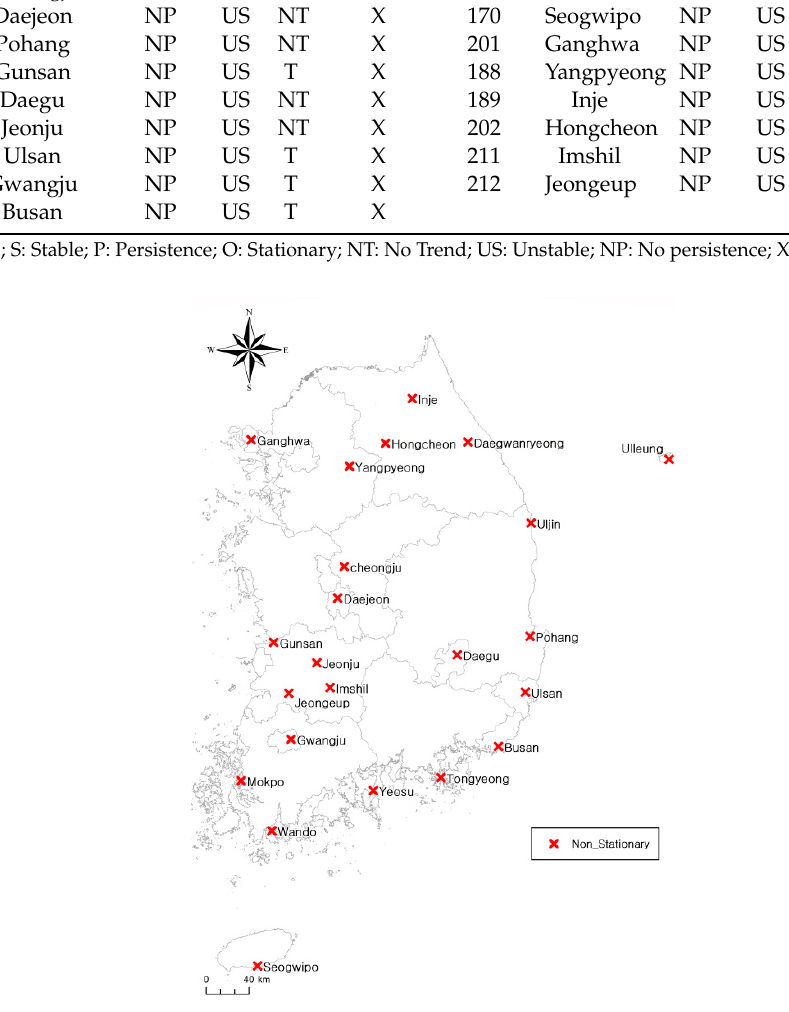
Figure 20. Results of the stationarity analysis using climate change scenarios.